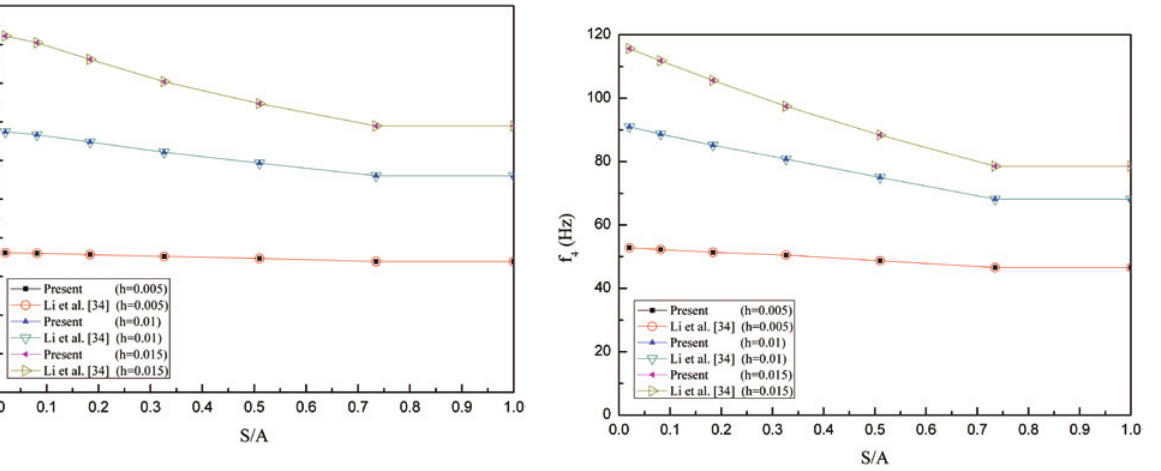
Figure 13 The fourth-order frequency of the clamped square com- posite laminates with different area of bonding imperfections.